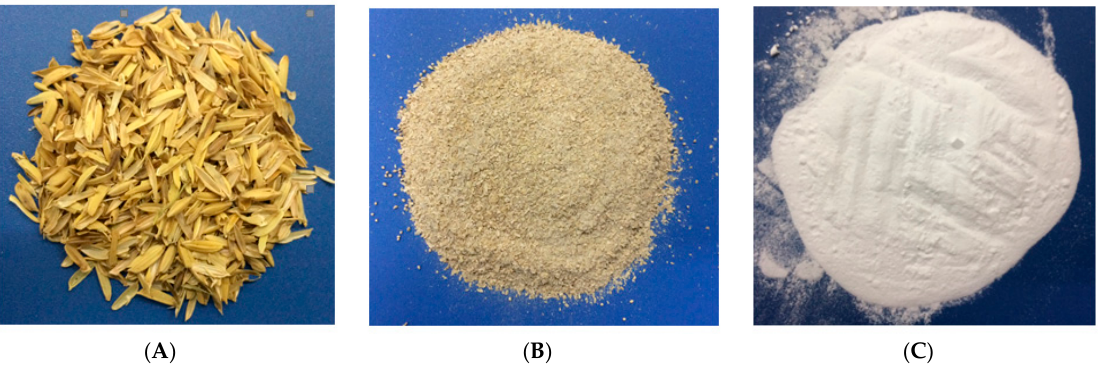
Figure 2. Pictures of ( A ) rice husk; ( B ) milled rice husk; and ( C ) synthesized nanosilica.